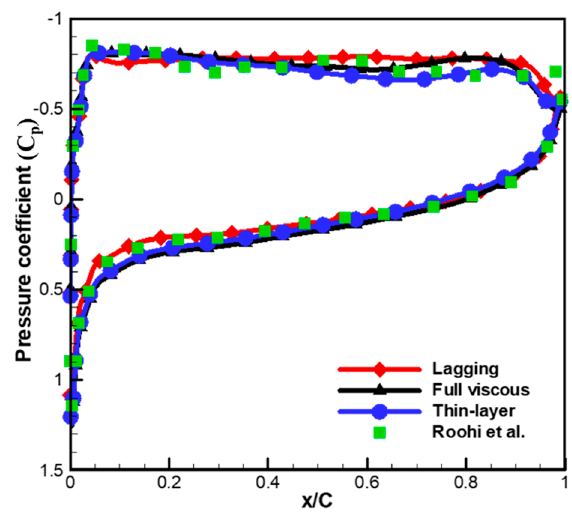
Figure 2. Comparison of predicted pressure coefficient distribution with large eddy simulation (LES) data by Roohi et al. [40].